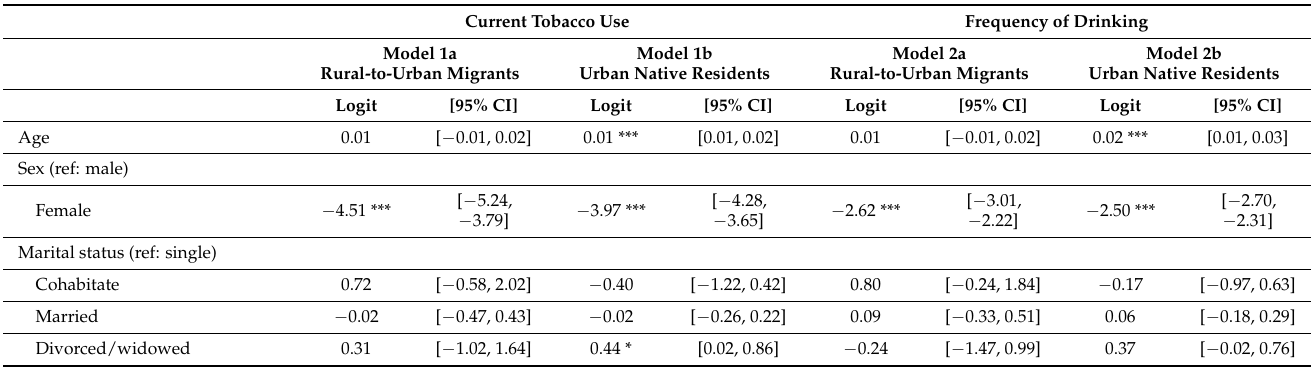
Table 3. The association between sociodemographic variables and tobacco use and alcohol use among migrants and urban native